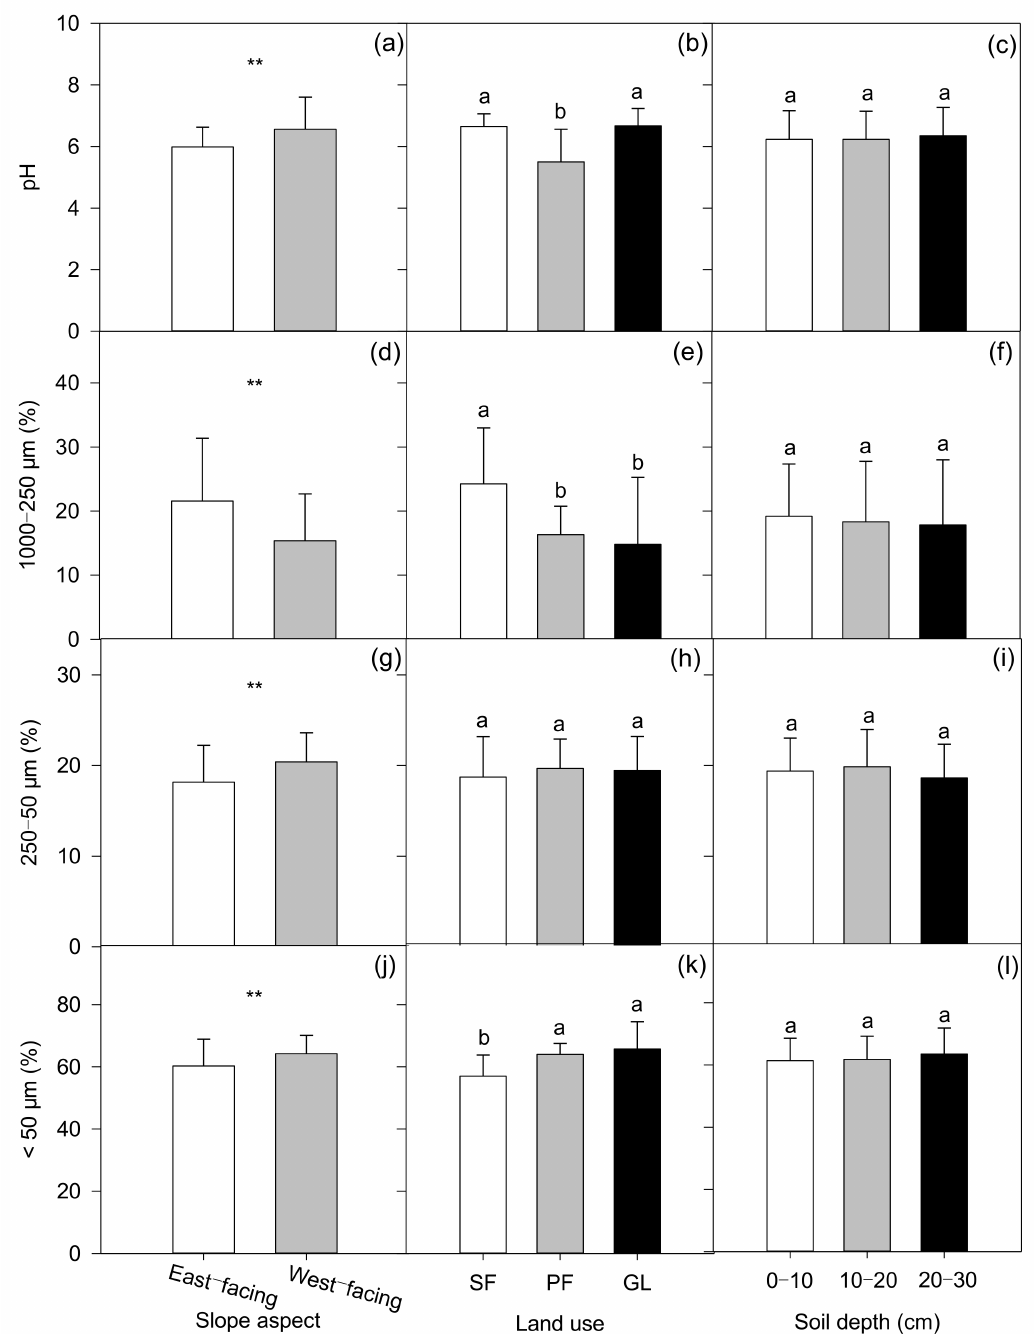
Figure 4. Soil pH ( a – c ) and relative mass distribution of micro-aggregate fractions: 1000 − 250 µ m ( d – f ), 250 − 50 µ m ( g – i ), and <50 µ m ( j – l ) affected by slope aspect, land use, and soil depth, respectively. Error bars represent standard deviation of means. “**” marked in the middle indicates significant difference between slope aspects. Different lowercase letters denote significant differences among land uses and soil depths, respectively. SF, secondary forest; PF, plantation forest; GL,